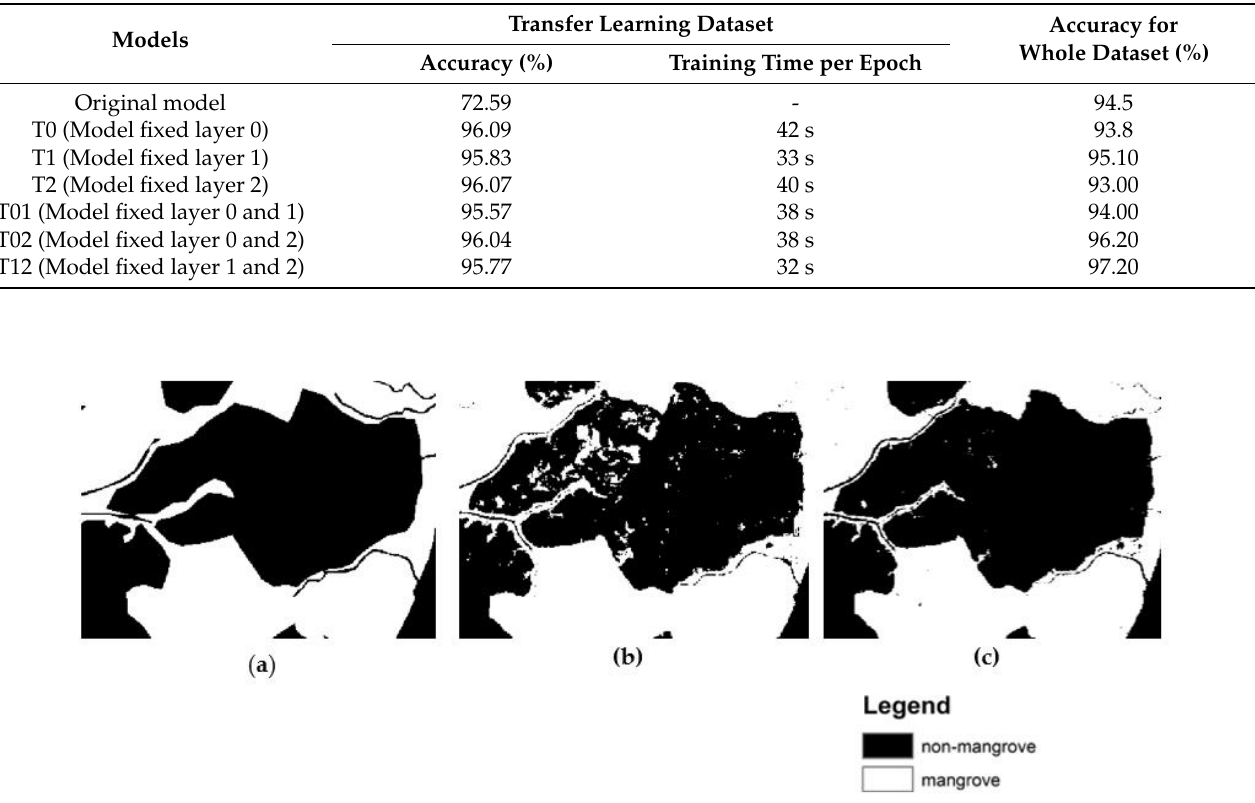
Table 4. Classification results of different models in transfer learning.